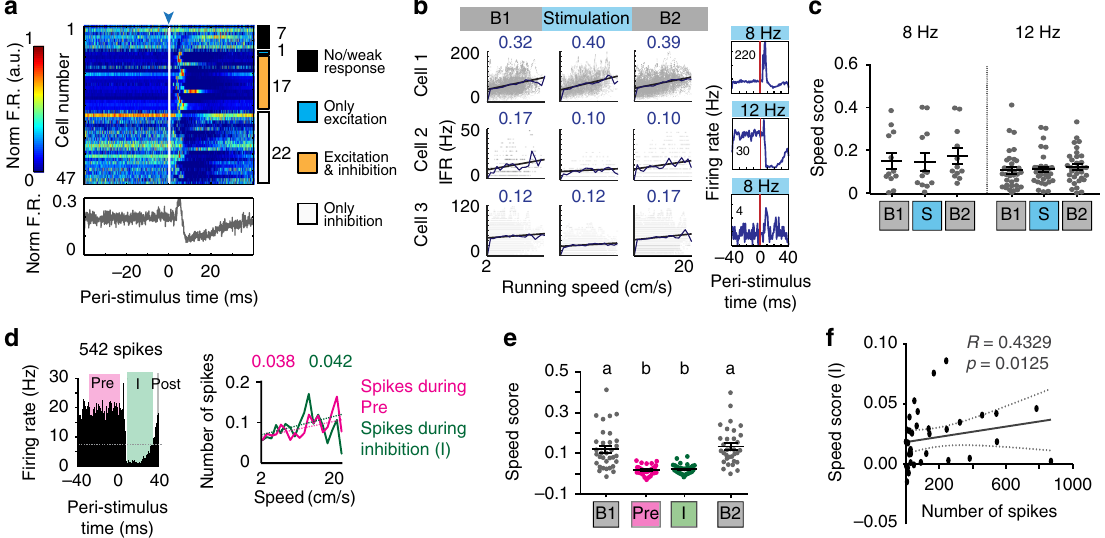
Fig. 3 Speed cells were transiently inhibited by LIIP stimulation. a Peri-stimulus time plot of all speed cells (32 principal cells, 15 interneurons). Each row is a cell with the fi ring rate scaled as in the color bar to the left. Cells are ordered by optogenetic response category with the number of cells in each category indicated to the right. The mean normalized fi ring rate over all speed cells is depicted below the plot, demonstrating a period of inhibition. b Example speed cells retained their speed scores (number on top of each plot) during the stimulation session regardless of response category. Optogenetic stimulation frequency is provided on top and peak fi ring rate is printed within the PSTH plots to the right. c Speed scores for stimulation sessions did not differ from baseline sessions. Each dot represents a cell [ n = 12 cells for 8 Hz sessions, 33 cells for 12 Hz sessions from 7 mice; two-way ANOVA with repeated measures on one factor, F (2,86) = 0.2367, p = 0.7898]. d Left, PSTH of a speed cell that was transiently inhibited by the optogenetic stimulation. Right, Correlation between instantaneous running speed and either the number of spikes during the period of maximum inhibition (I, green), or an equal number of spikes randomly sampled before light onset (Pre, magenta). Speed scores are shown above the plot. e Quanti fi cation of speed scores revealed no difference between Pre and I, but both scores were reduced compared to baseline [one-way repeated-measures ANOVA, n = 33 cells from 7 mice, F (1.858,59.45) = 44.94, p < 0.0001]. Signi fi cantly different groups (Tukey ’ s multiple comparisons test, p < 0.05) are assigned different letters (a, b). f There was a signi fi cant correlation between the speed score during inhibition (I) and the number of spikes during inhibition (I), suggesting that the decrease in speed score can be explained by the increased variability from low spike numbers [Spearman ’ s rank correlation, n = 34 cells from 7 mice, R = 0.4239, p = 0.0125]. Plots in c , e show the mean ±